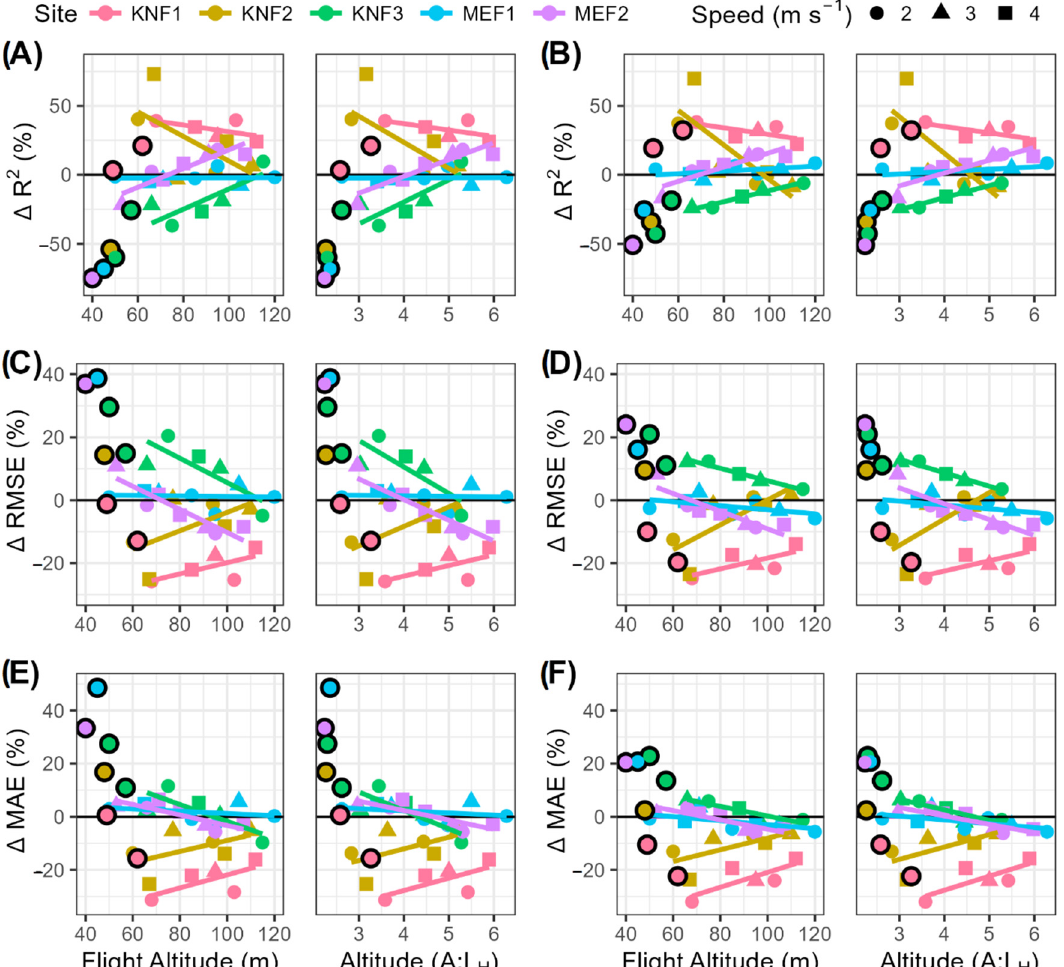
Figure 3. Comparison of Standard (panels ( A , C , E )) and Standard + NGRR (panels ( B , D , F )) AGB model performance metrics relativized to LiDAR, including percent ∆ R 2 (panels ( A , B )), ∆ RMSE ( C , D ), and ∆ MAE ( E , F ). The panel is split to show the influence of altitude above ground (left) and the ratio A:L H (right). Points in black circles represent acquisitions that failed to reconstruct the forest canopy fully and were therefore excluded from the best it lines. Table 2. Linear mixed-effects model of flight altitude and speed influence the change in above- ground biomass model R 2 ( ∆ R 2 ). A total of four models were created for combinations of the 37 Standard or 37 Standard + NGRR predictions with altitude or relative altitude as predictors; the five study sites were treated as a random effect.